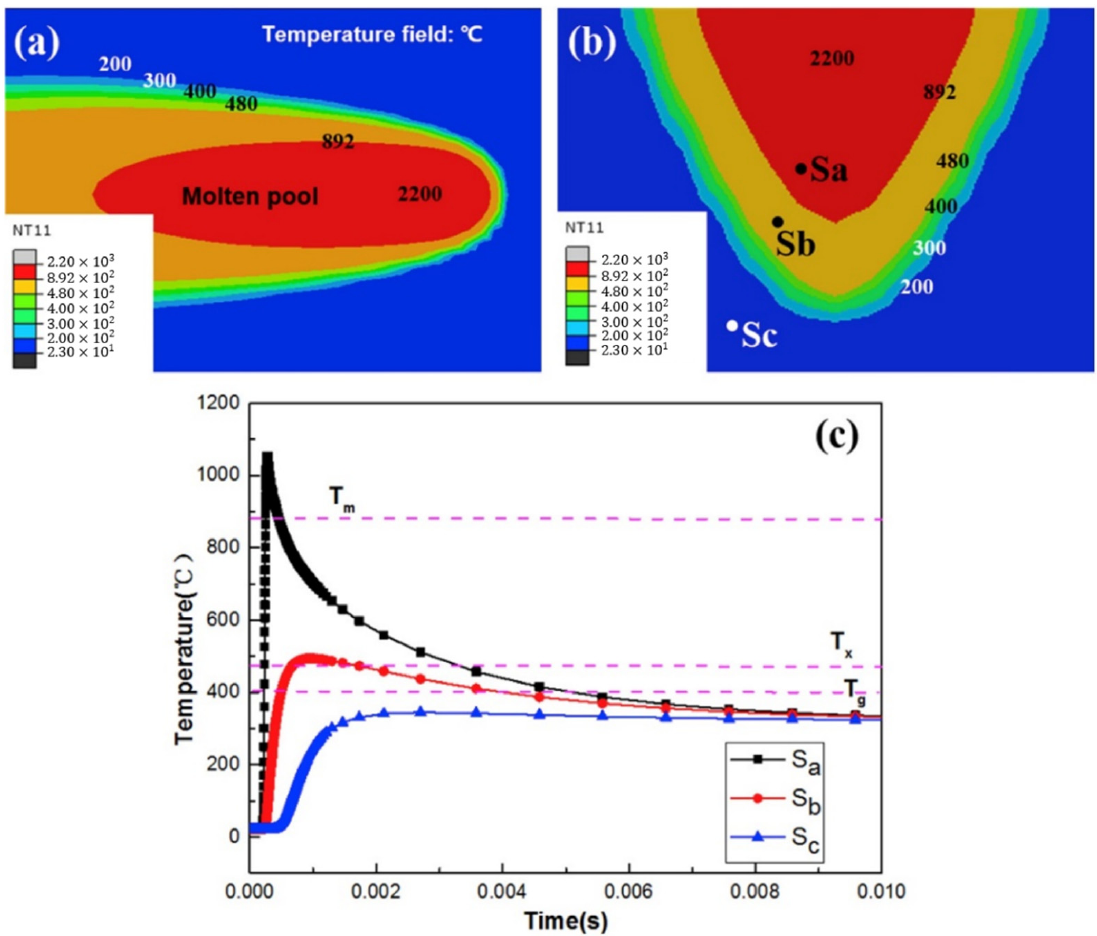
Figure 33. Thermal FEM simulation results of LPBF of a Zr-based BMG ( a ) top-view of the melt pool, ( b ) cross-section of the melt pool, and ( c ) thermal history of three points in ( b ). Reproduced from [86], with permission from Elsevier, 2021.